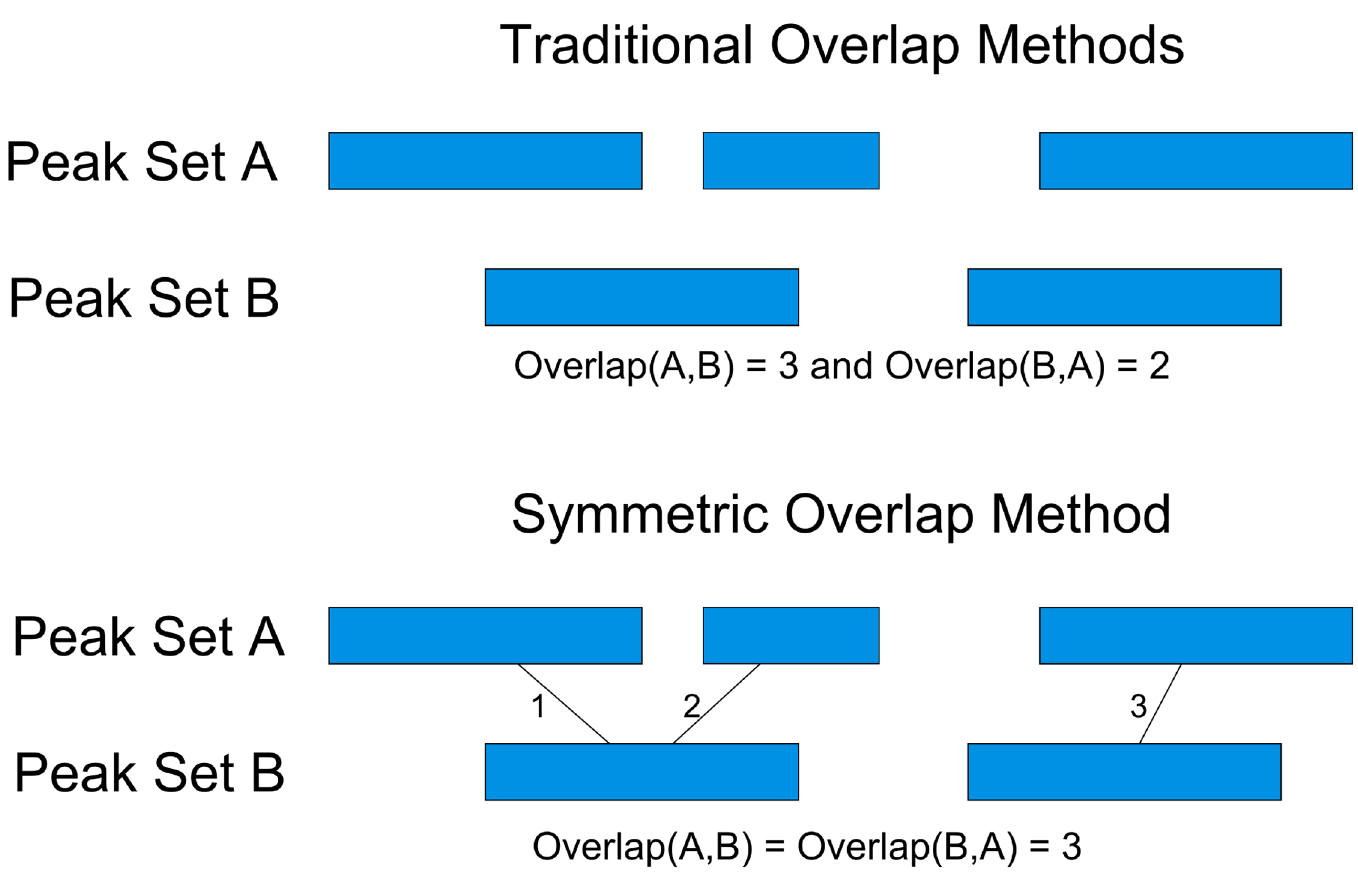
Fig 7. PAPST ’ s Symmetric Overlap of Peak Regions. PAPST uses a novel overlap algorithm which counts the number of edges drawn between overlapping peaks. This method ensures that two sets, A and B, produce a symmetric overlap relationship where Overlap(A,B) = Overlap(B,A).